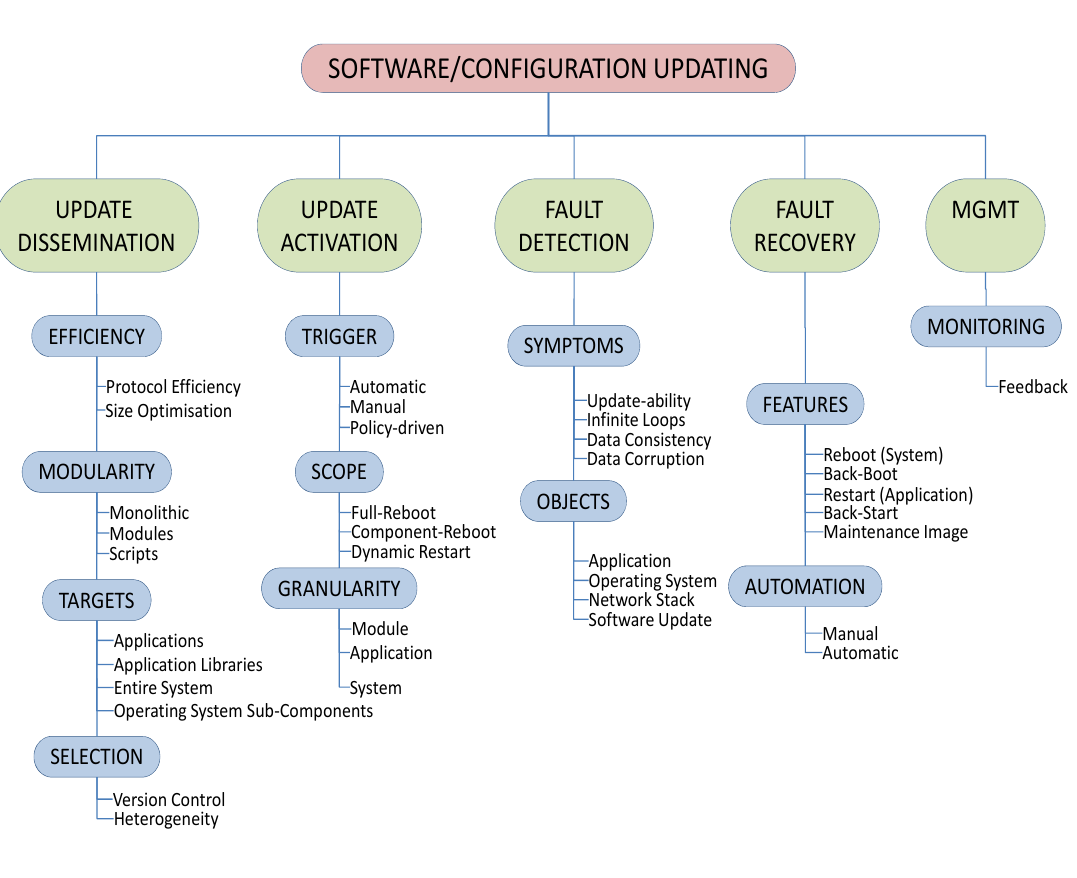
Figure 7. Taxonomy of Update